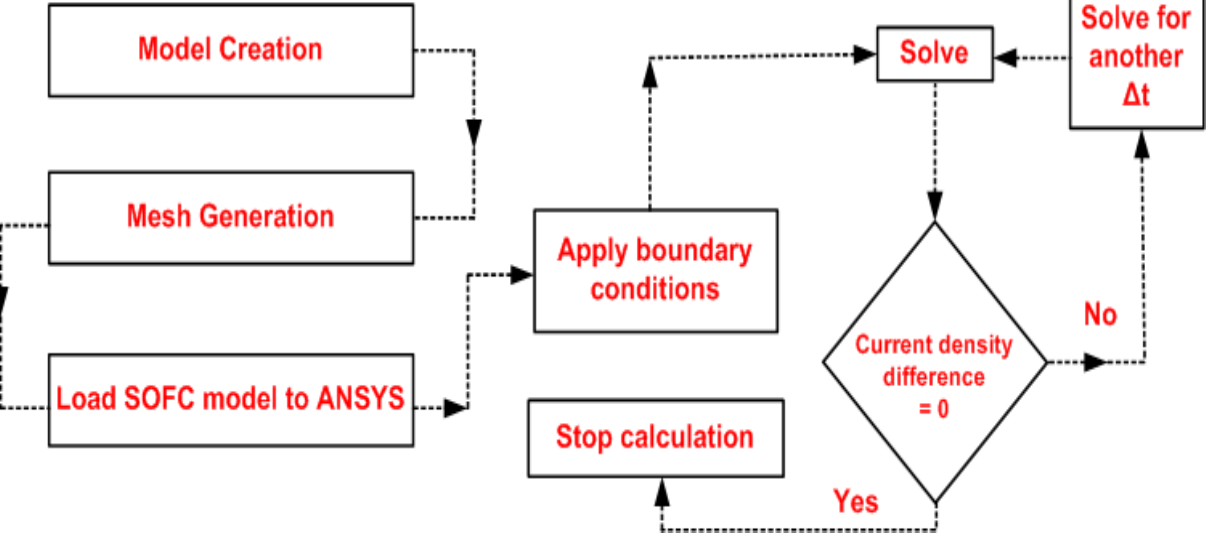
Figure 3. Numerical procedure flowchart used in this study.